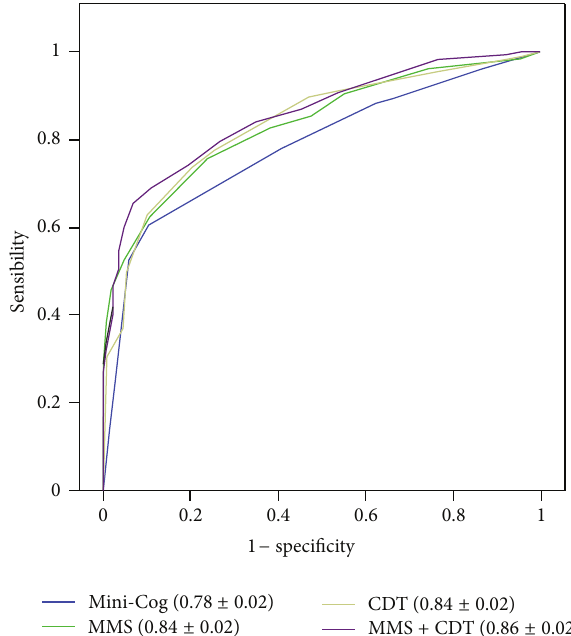
Figure 1: Frequency of Mini-Cog individual scores according to cognitive diagnosis. CI: cognitive impairment; MCI: mild cognitive impairment; NC: normal cognition.